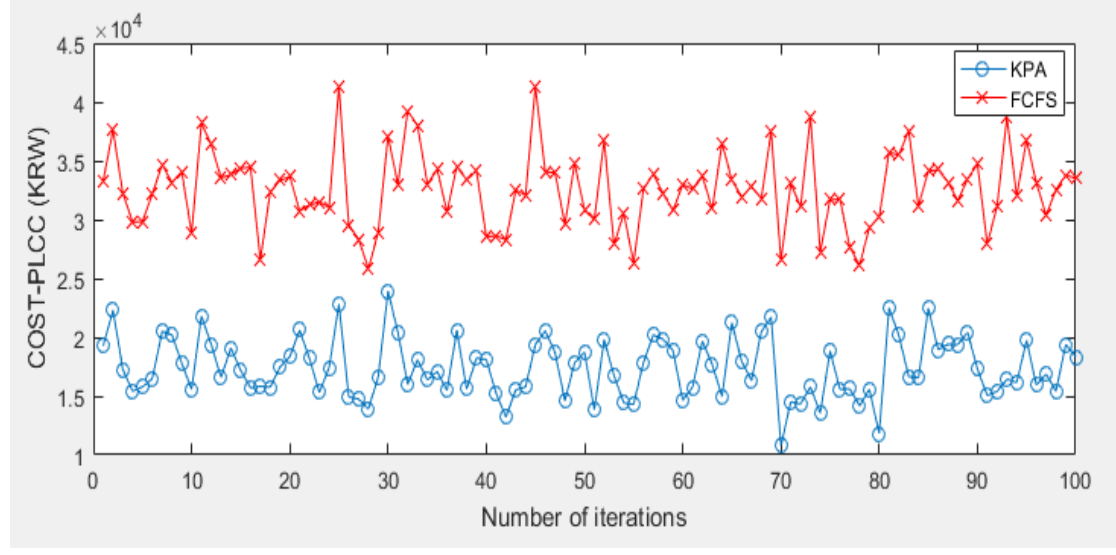
Figure 10. Results of total COST for the PLCC in Case (7): demand 400 kW, 80 EVs.